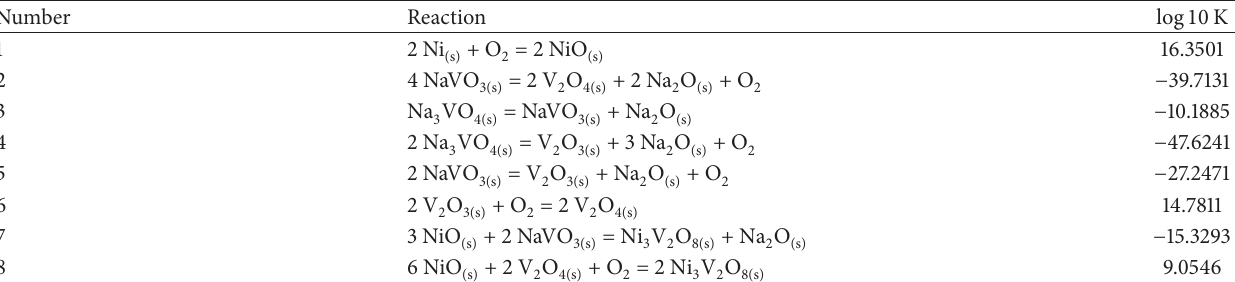
Table 3: Chemical reactions and equilibrium constants for the Ni-Na-V-O system at 700 ∘